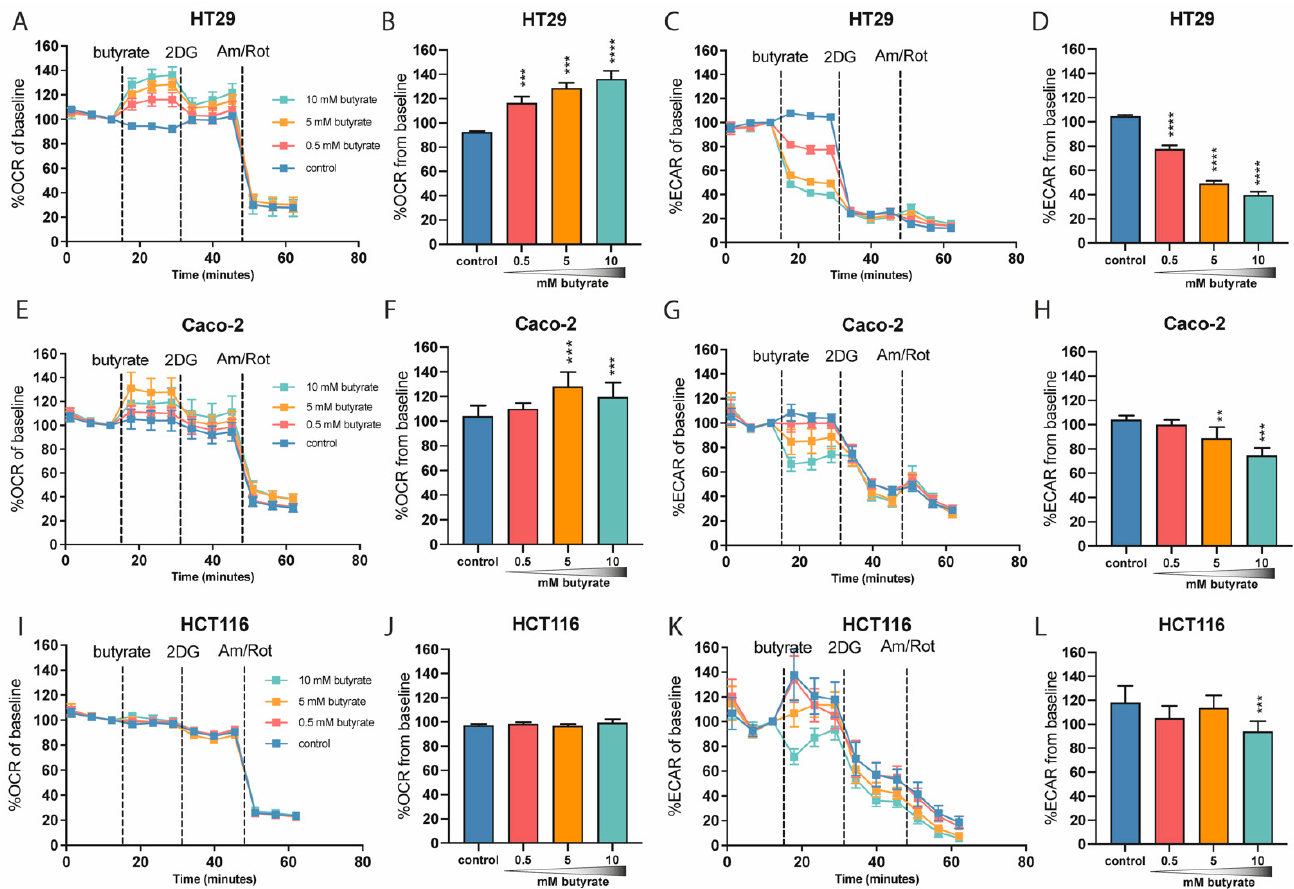
Figure 3. Metabolic flux analysis of multiple colon-derived cell lines following acute butyrate exposure. ( A – D ) 25 mM cultured HT29 cells (representative experiment of N = 4 independent experiments consisting of n = 5–6 wells). ( E – H ) Caco-2 cells (representative experiment of N = 3 independent experiments consisting of n = 9–15 wells). ( I – L ) HCT116 cells (representative experiment of N = 3 independent experiments consisting of n = 12 wells; significance was determined for one representative experiment using repeated-measures ANOVA followed by Bonferroni’s post-hoc analysis. p < 0.01 = **, p < 0.001 = ***, p < 0.0001 = ****).